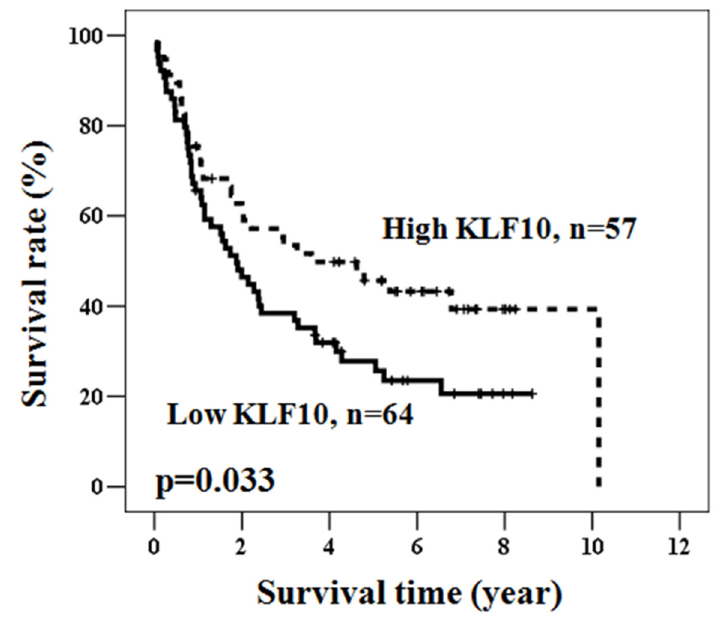
Figure 2. The prognostic significance of KLF10 in gastric cancer. Kaplan–Meier survival curve for the 121 gastric cancer patients with KLF10 protein expression. Patients with high KLF10 expression had a significantly better overall survival rate compared to patients with low KLF10 expression, as defined by a log-rank test ( p = 0.033).